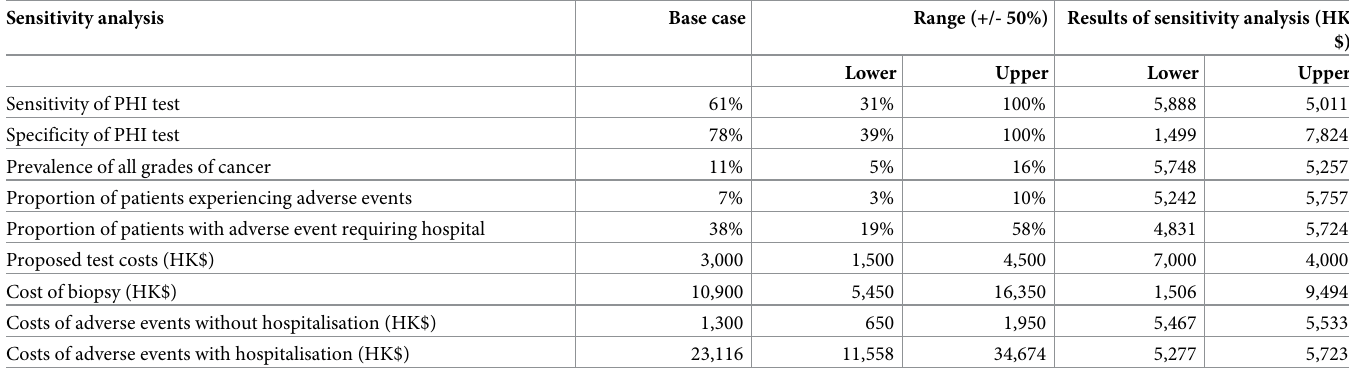
Table 4. Sensitivity analysis.